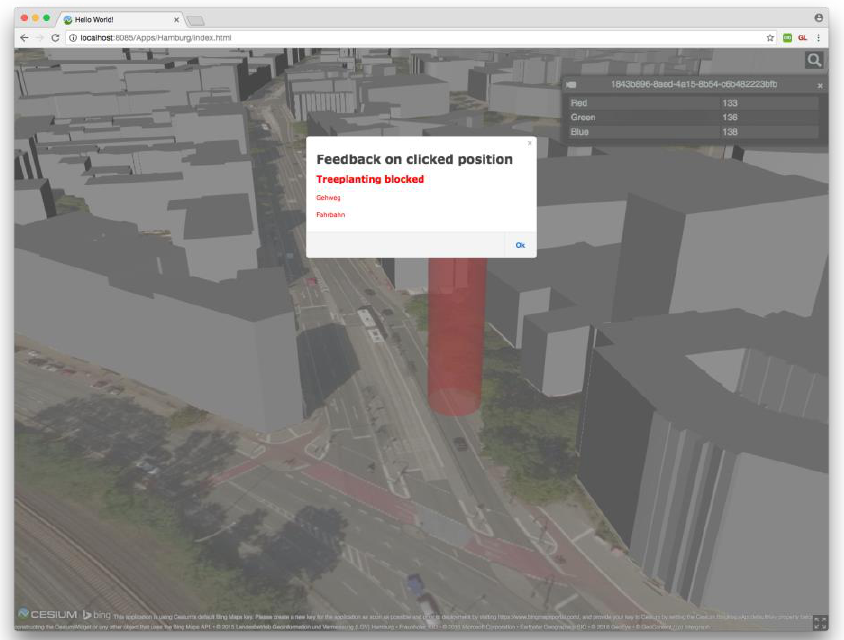
Figure 10. Negative Feedback on a selected position.